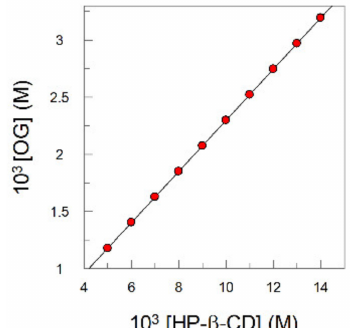
Figure 7. Changes of the concentration of octyl (OG) solubilized in the presence of increasing concentrations of 2–hydroxypropyl– β –cyclodextrin (HP– β –CD) by employing phase-solubility method, T = 25 ± 1 ◦